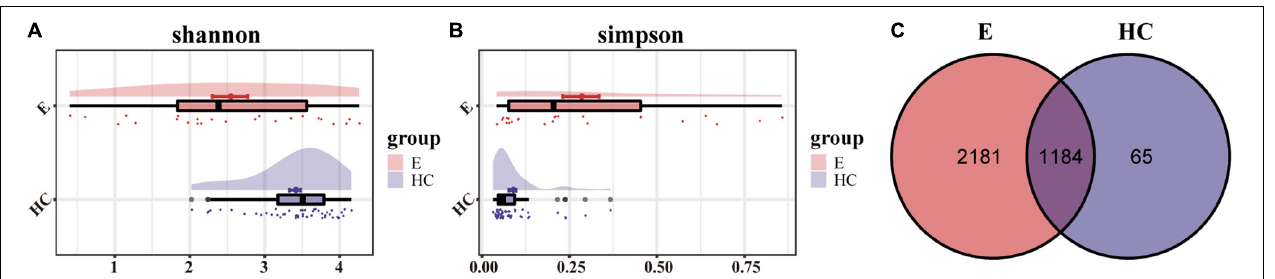
Frontiers in Microbiology |